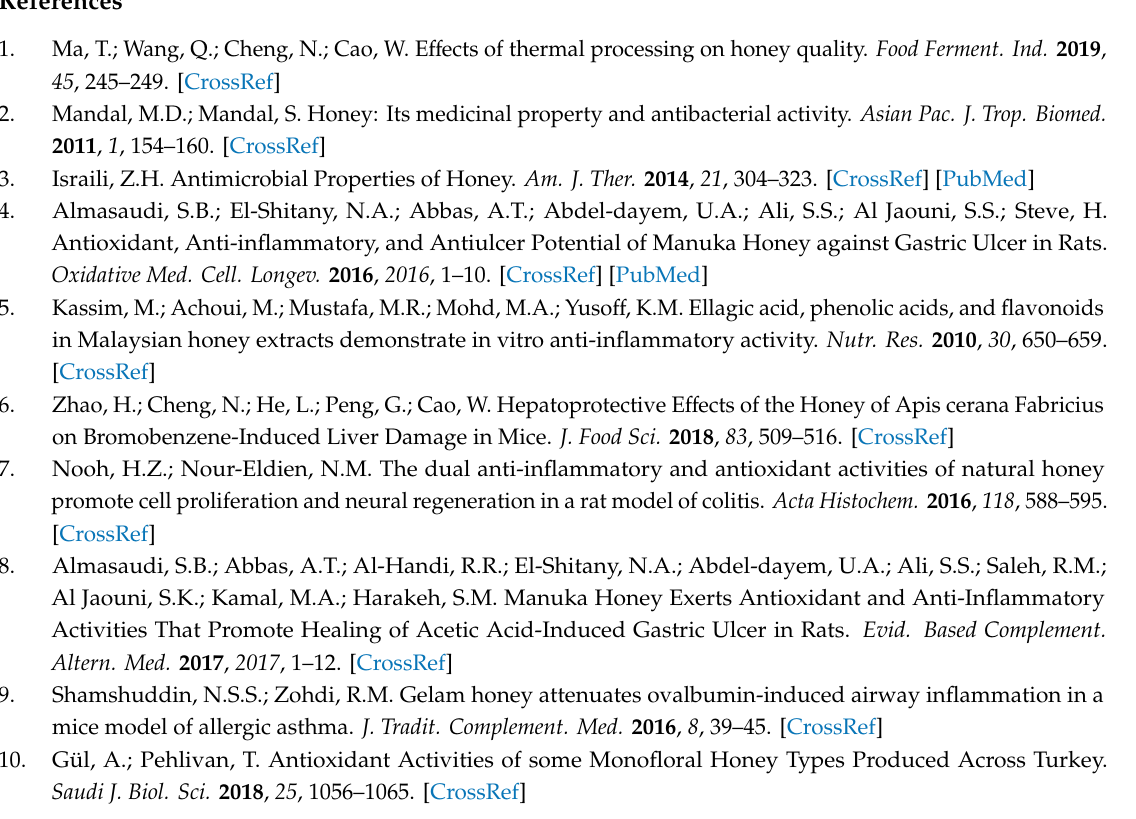
Figure S1: Micrograph of sa ffl ower pollen from a sa ffl ower honey